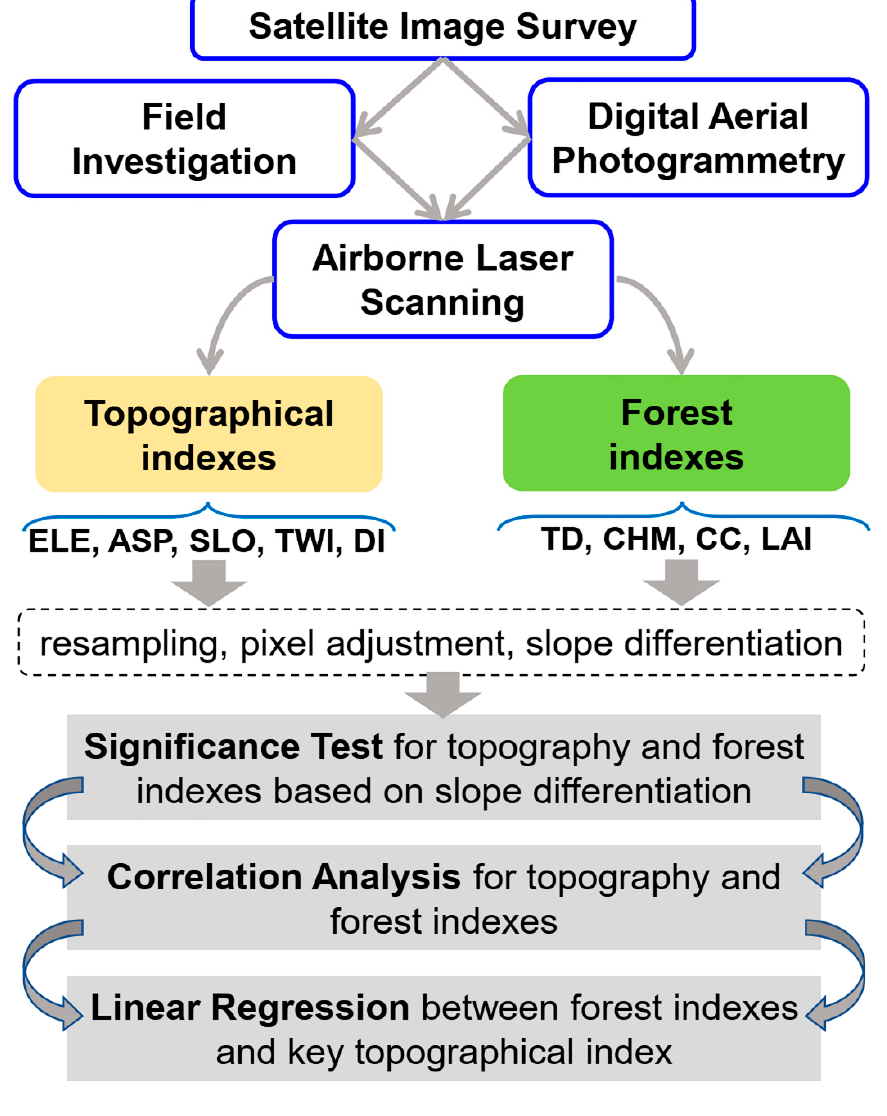
Figure 2. Conceptual framework of characterizing the effects of topography on trees in this study. The topographical indexes: ELE, elevation; ASP, aspect; SLO, slope; TWI, topographic wetness index; DI, direct insolation. The forest indexes: TD, tree density; CHM, canopy height model; CC, canopy cover; LAI, leave area index.